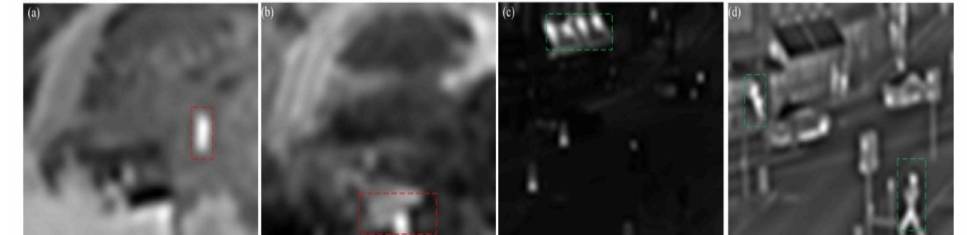
Figure 2. The salient target in the low level coefficient. ( a ) The low-frequency band of the infrared image for the first group; ( b ) the low-frequency band of the visible image for the first group; ( c ) the low-frequency band of the infrared image for the second group; and ( d ) the low-frequency band of the visible image for the second